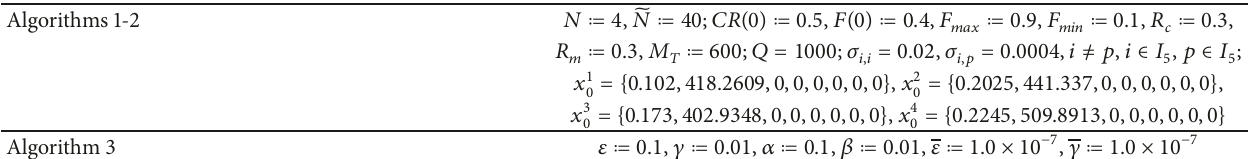
Table 2: The parameter value of Algorithms 1–3.